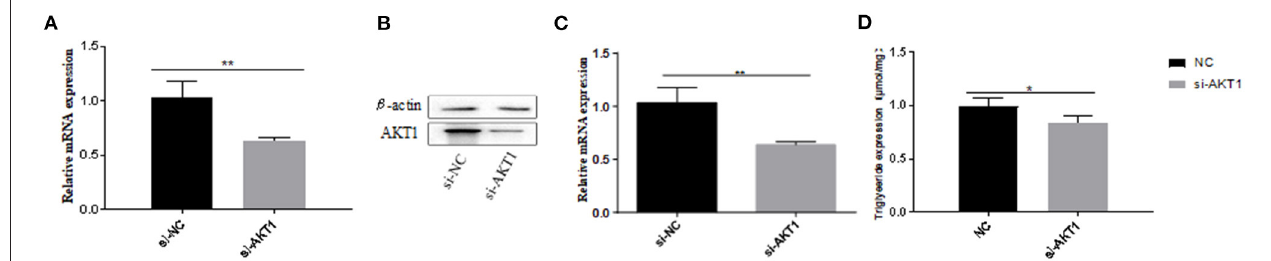
FIGURE 6 | Effects of AKT1 on the metabolism of adipocytes in Qinchuan cattle. (A) The efficiency of si-AKT1 transfection; (B,C) The expression levels of AKT1 mRNA and protein in pre-adipocytes transfected with si-AKT1 and negative control cells were compared; (D) After si-AKT1 treatment, the triglyceride level in pre-adipocytes decreased. Error bars represent mean ± SD. n = 3 replicates. *denotes significance according to Student’s t -test, * p < 0.05, ** p < 0.01, and *** p <